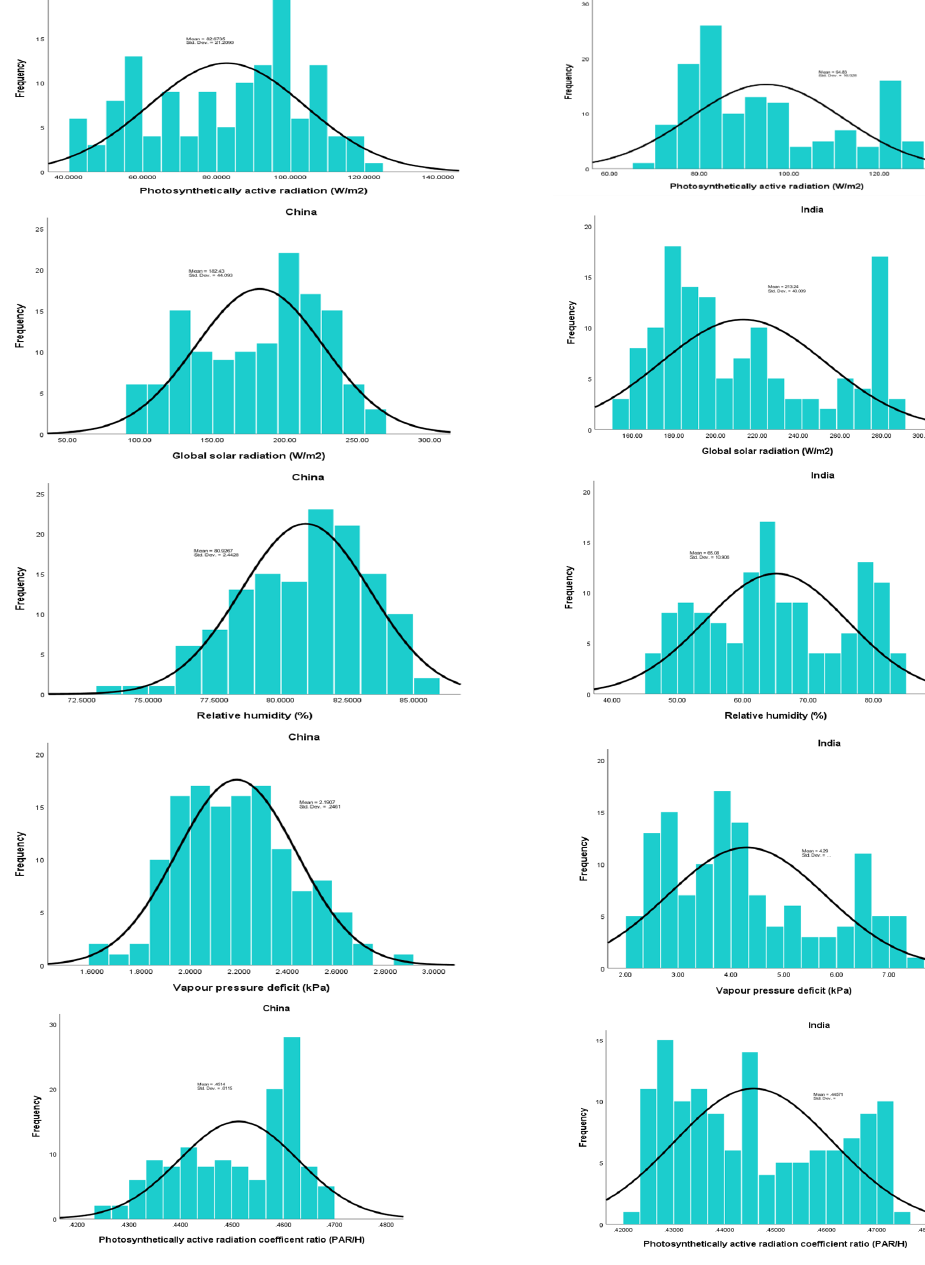
Figure 1. Descriptive statistics of input and output parameters for China (left hand column) and India (right hand column).